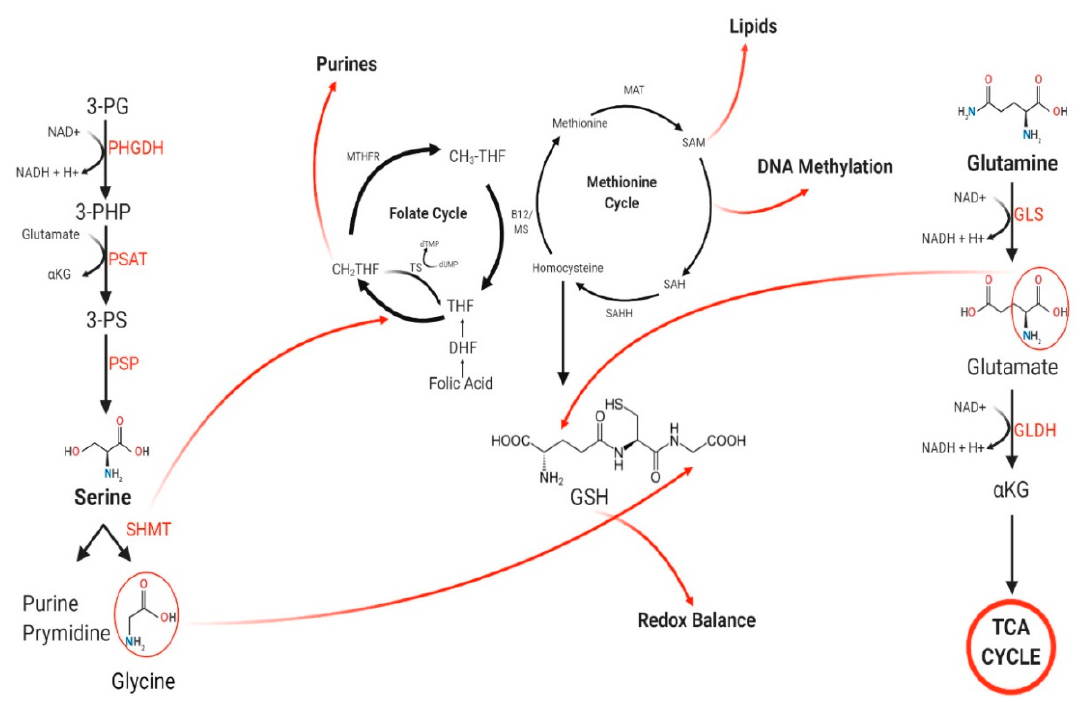
Figure 1. Schematic of the interaction between the three metabolic pathways (serine biosynthesis, 1-C metabolism, and glutamine metabolism). Serine is synthesized from 3-phosphoglycerate (3-PG) by phosphoglycerate dehydrogenase (PHGDH), phosphoserine aminotransferase (PSAT), and phosphoserine phosphatase (PSP). Serine is further converted to glycine by SHMT, which donates a carbon to the folate cycle. Tetrahydrofolate (THF) is converted to CH3THF by TS and MTHFR to complete the folate cycle. During demethylation of CH3THF, a carbon is donated to the methionine cycle by Vitamin B12. Methionine is synthesized to homocysteine by methionine adenosyltransferase (MAT) and SAAH, producing S-adenosylmethionine (SAM) and S-adenosylhomocysteine (SAH). Glutamine is converted to glutamate by the enzyme glutaminase. The side chain of glutamate is then used to form GSH. Abbreviations